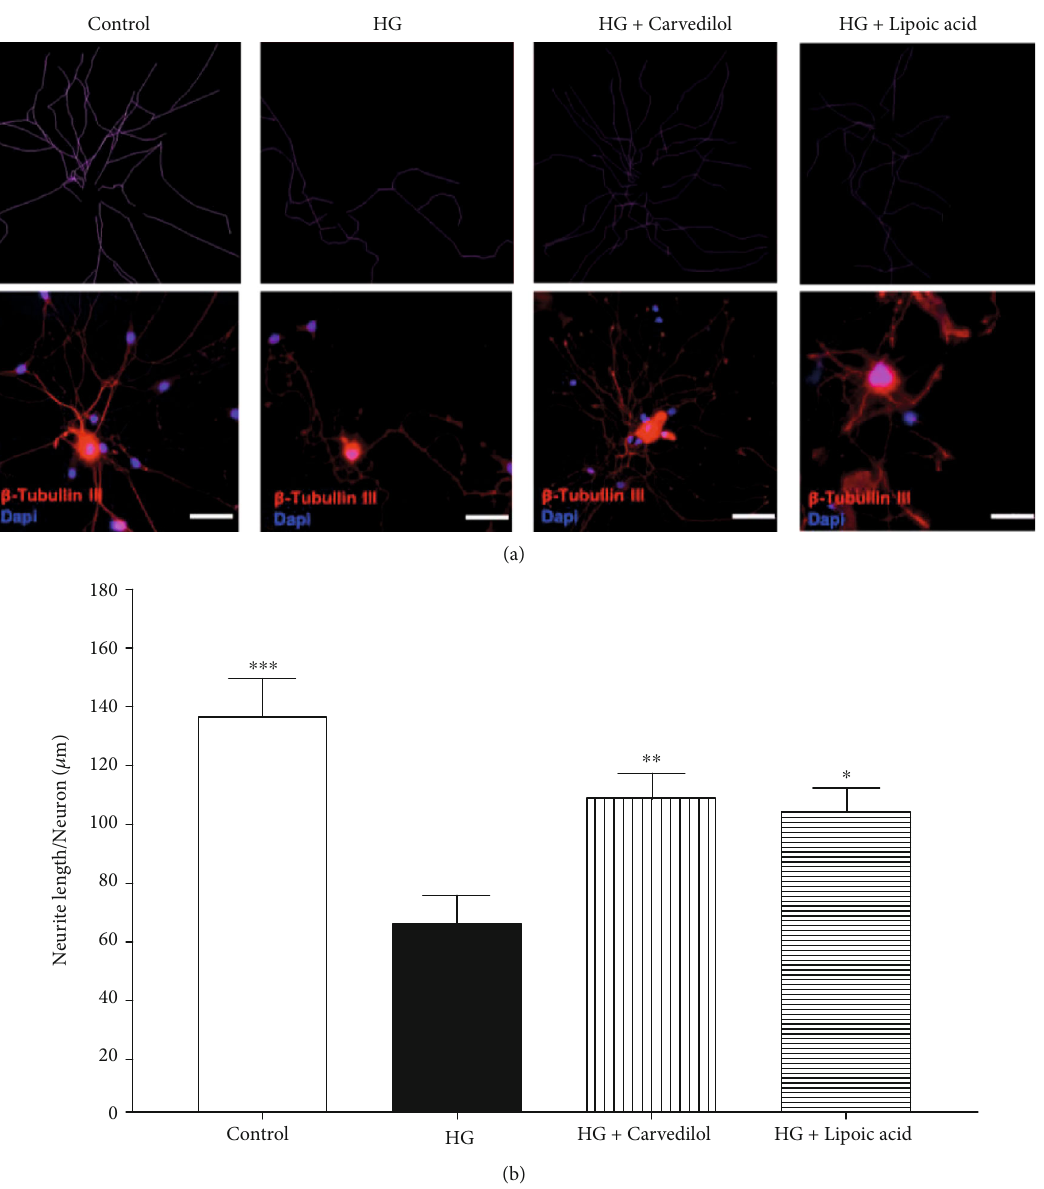
Figure 5: E ff ect of the carvedilol on neurite length in high-glucose